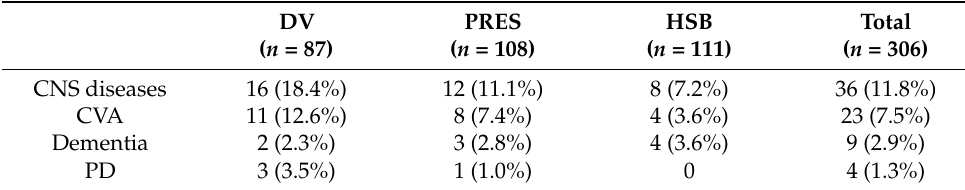
Table 2. The distribution of patients with central nervous system diseases stratified by different voiding dysfunction